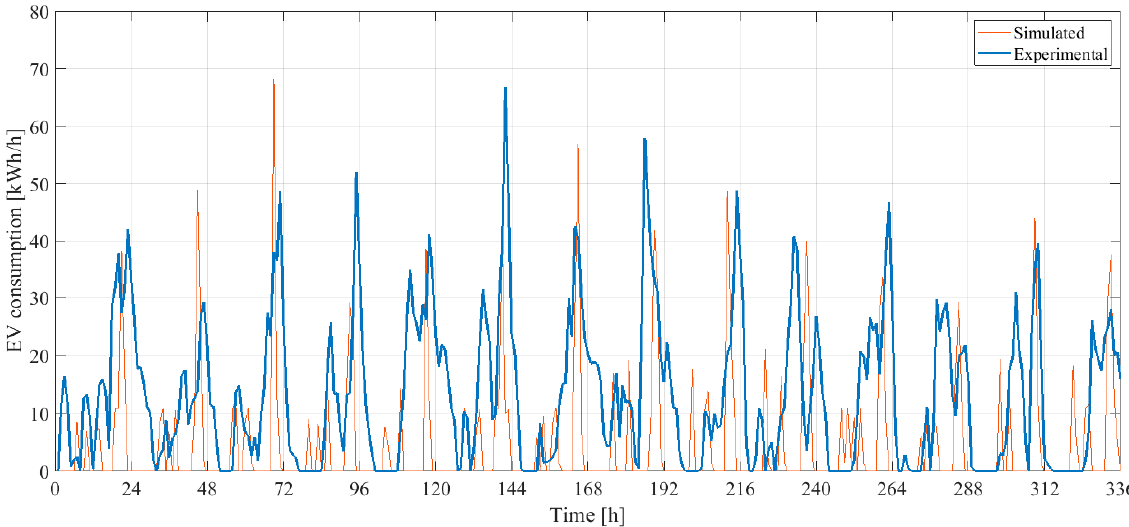
Figure 7. Comparison between the experimental data, measured at the car park, and simulated EV charging curve during 14 days (1st to 14th of December 2021).